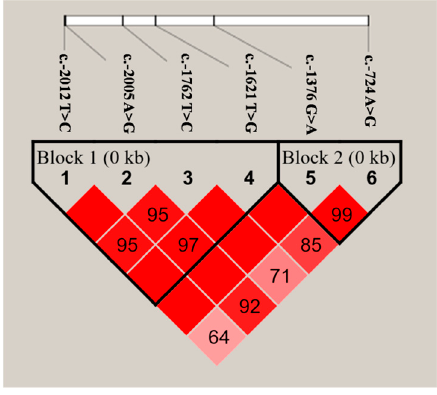
Figure 3. Linkage disequilibrium (LD) among the six SNPs in PDE9A . The value for r 2 between each selected SNP is presented in each box.